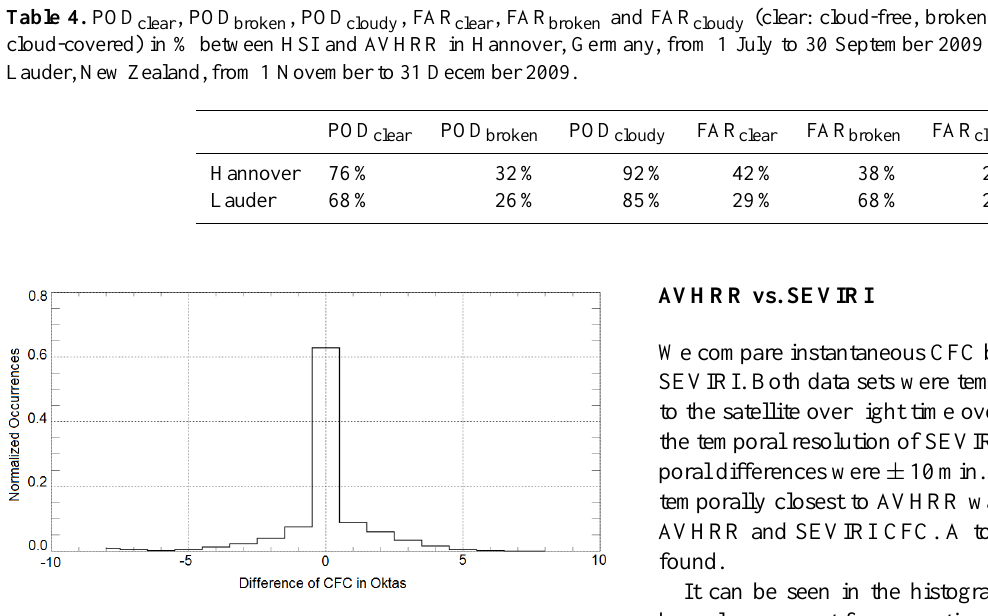
Figure 4. Histogram of instantaneous CFC differences between AVHRR and HSI in Hannover, Germany, from 1 July to 30 Septem- ber 2009. The occurrences are normalized with their respective total count. Negative differences express an underestimation of the CFC by AVHRR compared to HSI; positive differences express an over-